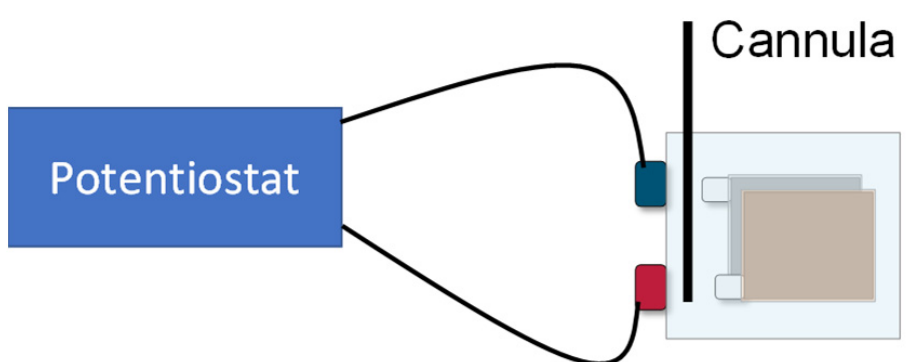
Figure 2. Experimental setup for the electrochemical investigation of the electrolyte wetting. Special test cells were connected before electrolyte filling to a potentiostat. The electrochemical measurements were started simultaneously with the electrolyte